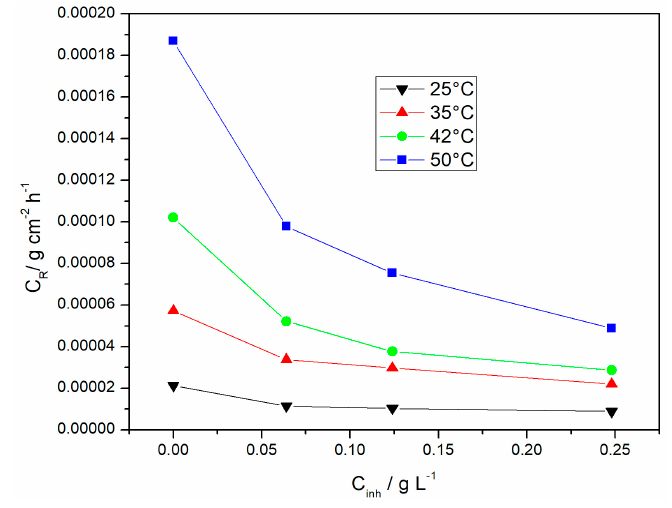
Figure 2. Corrosion rate (C R ) of aluminum in 0.1 M HCl containing various concentrations of Ilex paraguariensis extract (C inh ) at different temperatures.